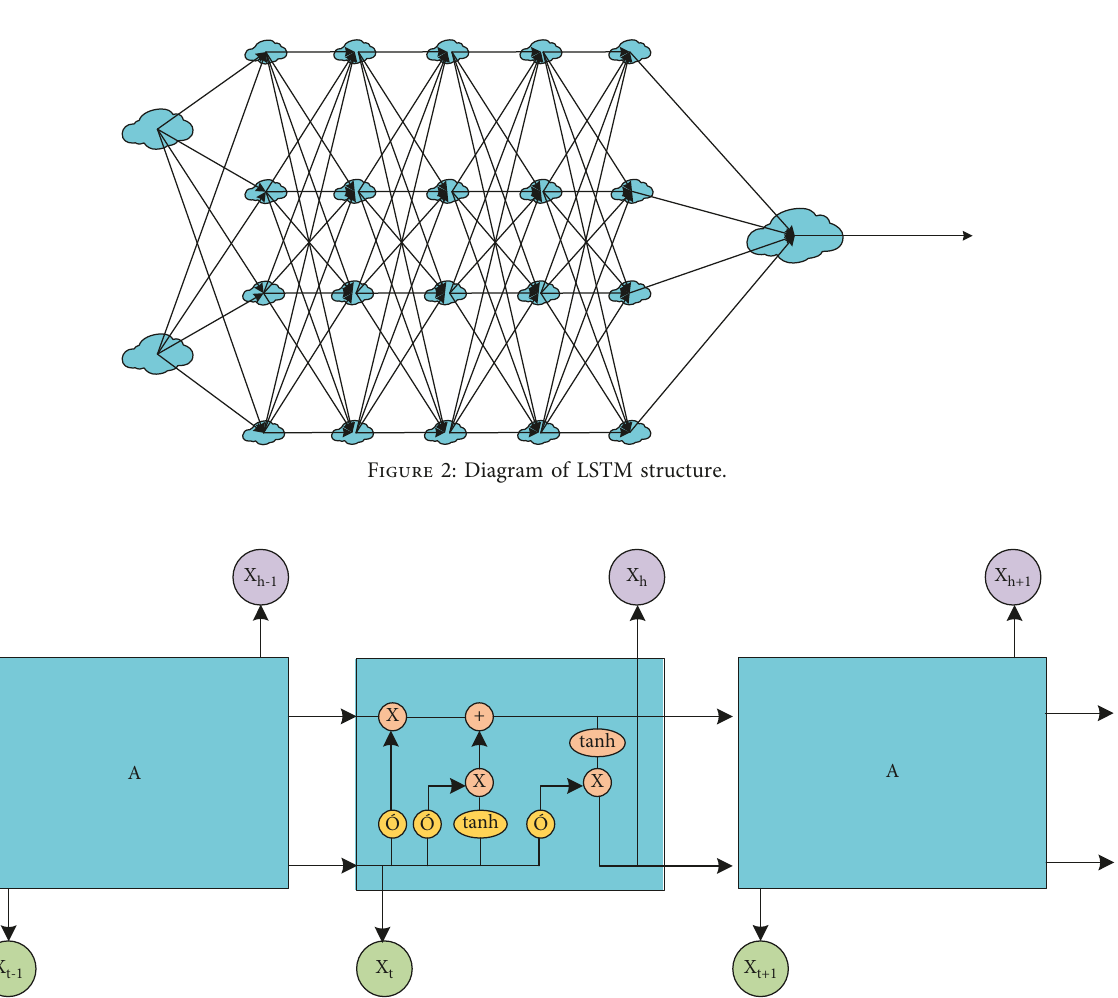
Figure 3: Internal structure diagram of LSTM.